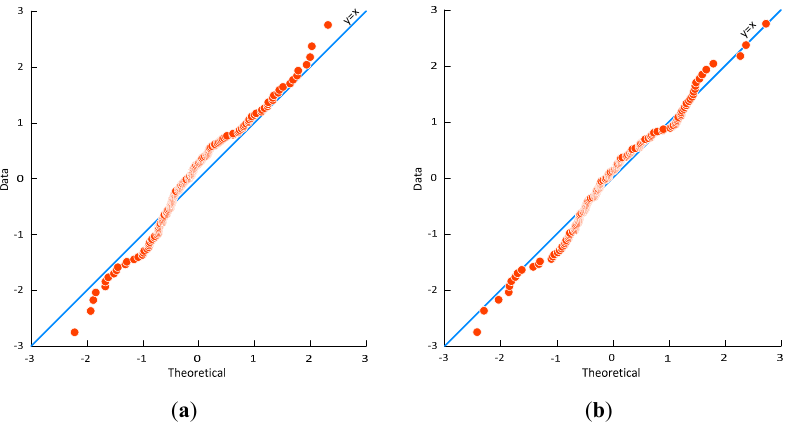
Figure 17. Q-Q plot, dataset 3. ( a ) T = 1.50 s; ( b ) T = 2.00 s.